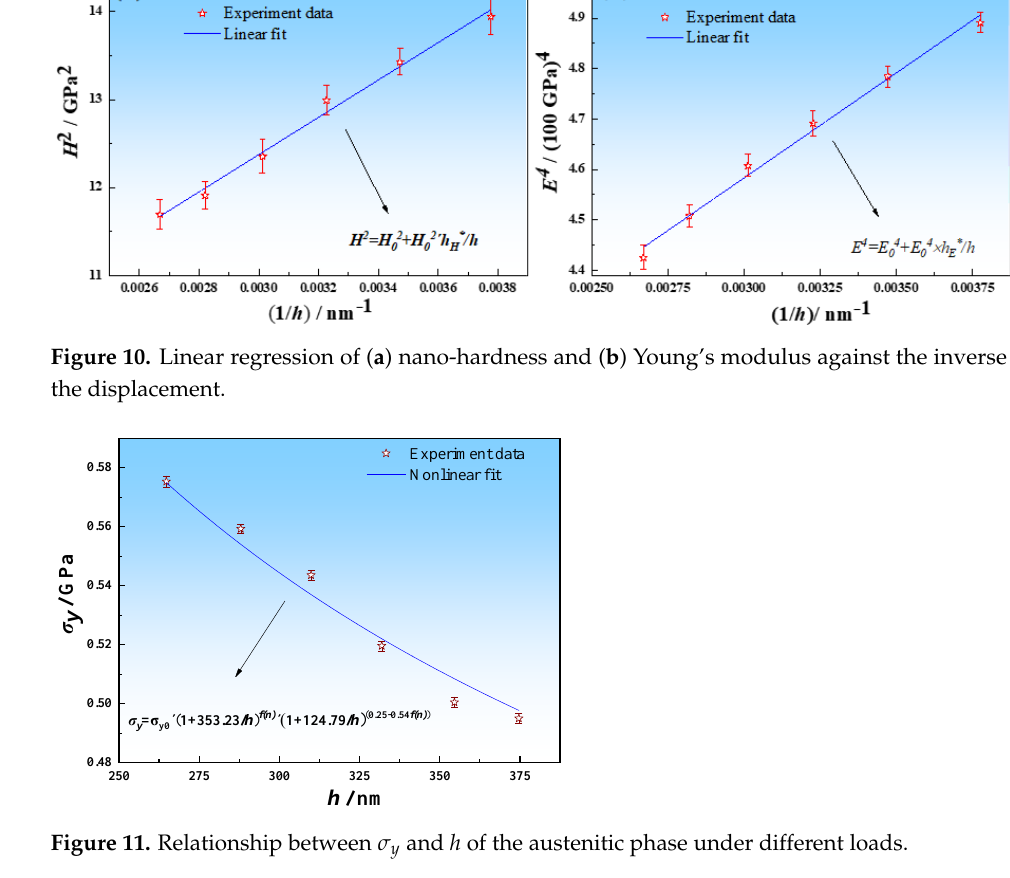
Figure 9. Three-dimensional shapes of indentations under 12 mN. ( a ) is the three-dimensional shapes of austenite and ( b ) is the three-dimensional shapes of σ -phase.